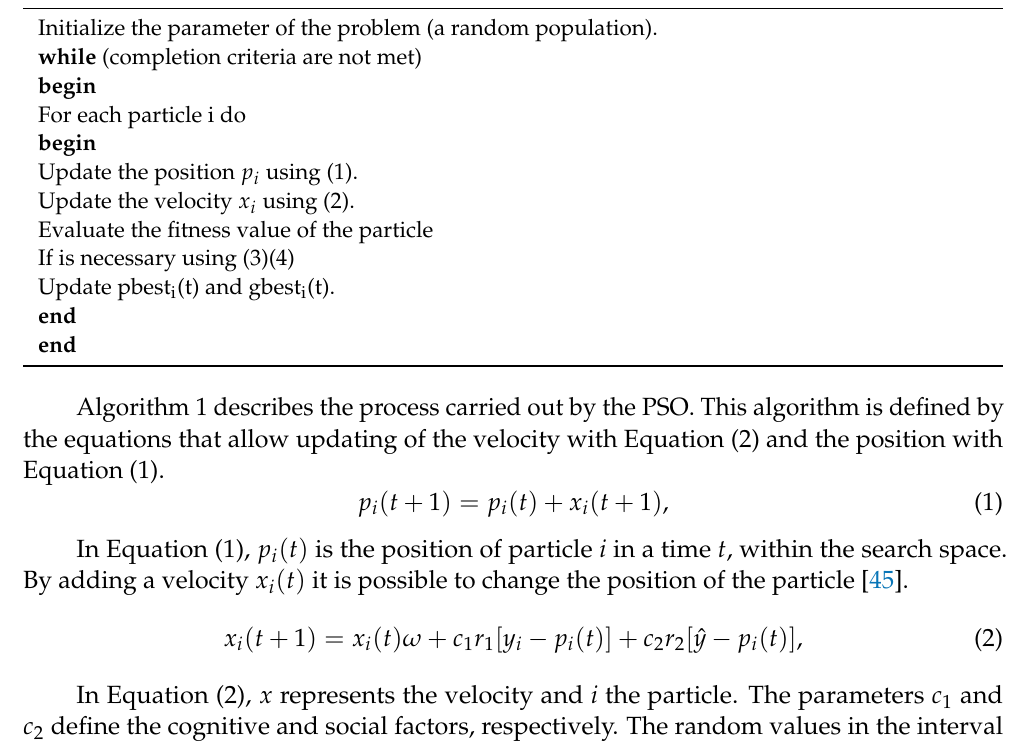
Algorithm 1. The PSO